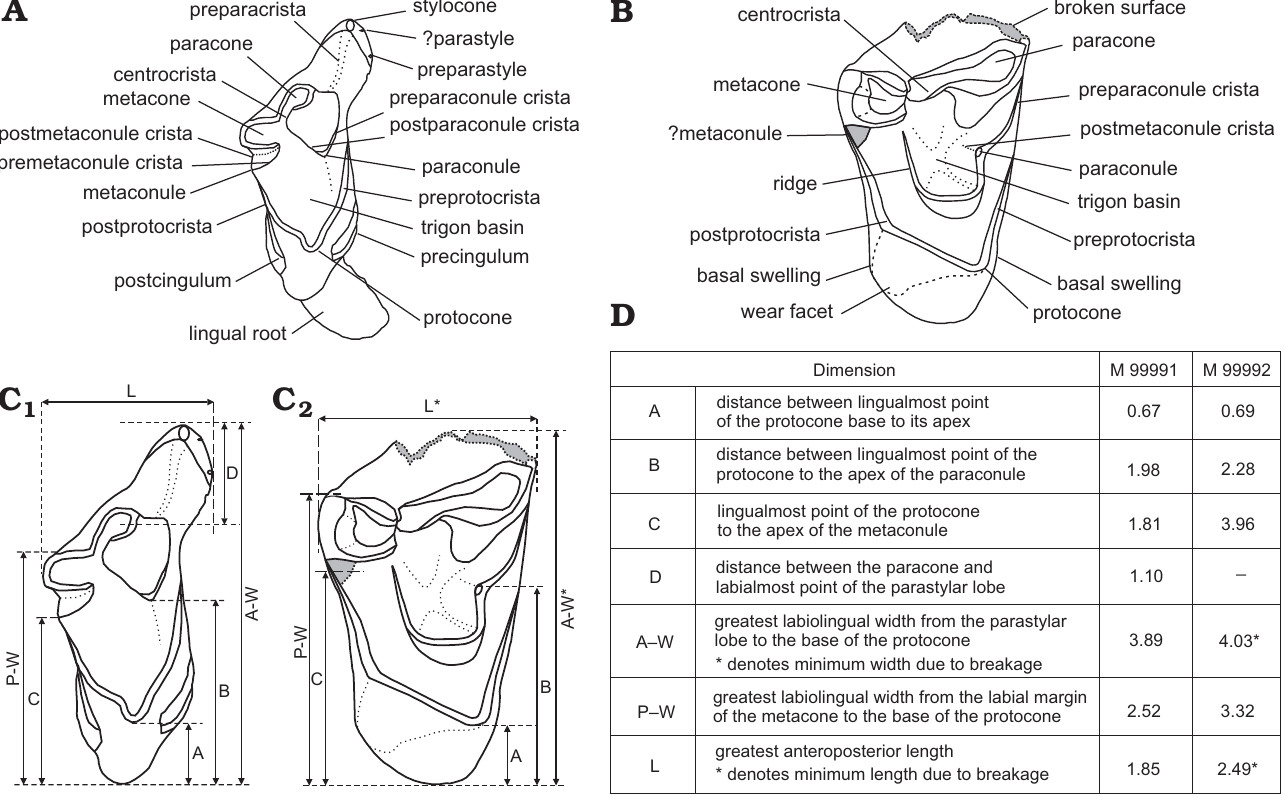
Fig. 3. Interpretive line drawings of teeth of the eutherian mammals Durlstotherium newmani gen. et sp. nov., NHMUK PV M 99991 ( A ) and Durlstodon ensomi gen. et sp. nov., NHMUK PV M 99992 ( B ) from the Purbeck Group exposed in Durlston Bay, Dorset, UK, in occlusal view, showing dental ter- minology ( A , B ) and dental measurements ( C , D